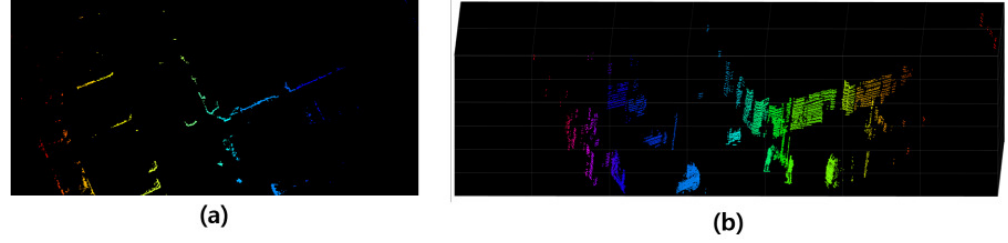
Figure 3. Segment generation on 3D point clouds. ( a ) 2D occupancy grid mapping results and ( b ) segmentation result on 3D point clouds.